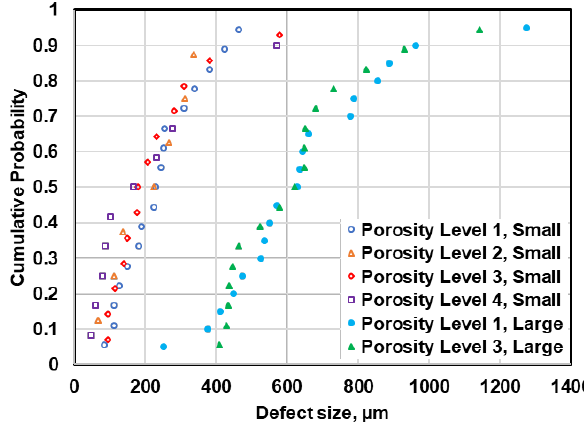
Figure 9. Comparison of defects distributions in different porosity levels based on observed defects on fracture surfaces.